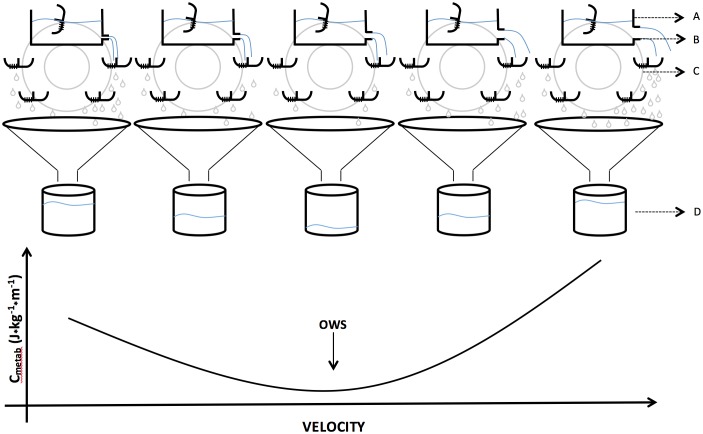
Idealization of metabolic cost (Cmetab) of walking based on adaptation of hydraulic model by Margaria (1976) with a watermill, representing the diameter of tube (aerobic Pmetab, Pmetab – B) releasing energy/liquid (aerobic capacity tending to infinity – A) on the blades of a watermill (energy transduction between potential and kinetic energy – C). The water remaining on the blades returns to the reservoir (energy minimization) and the water that falls into the funnel represents Cmetab
(D). Internally, the blades have two compartments (one side leaked and one not) and remain all the time facing up except for the moment when they pass through the reservoir. This model represents what might be expected into the relationship between Pmetab and Cmetab at progressive walking speeds under the action of an energy minimizing mechanism, that is, how the increase in power is related to the cost. The optimal walking speed (OWS) represents the velocity in which the Cmetab is lower.